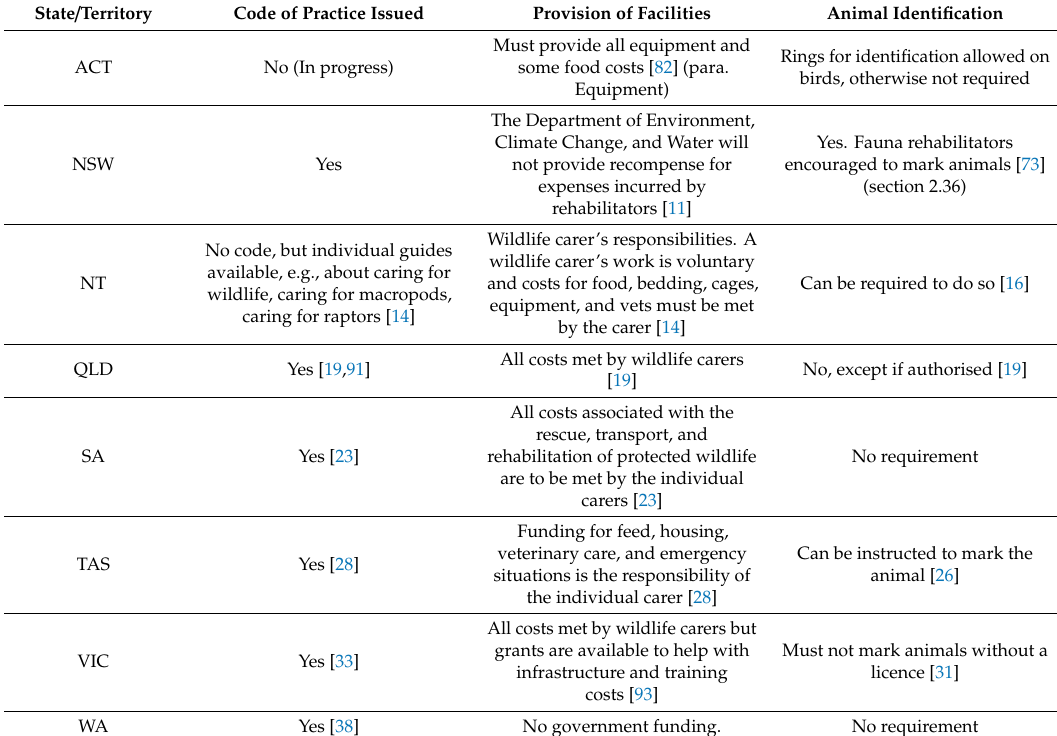
Table 4. Standards of care, facility requirements, and identifying of animals in the states and territories of